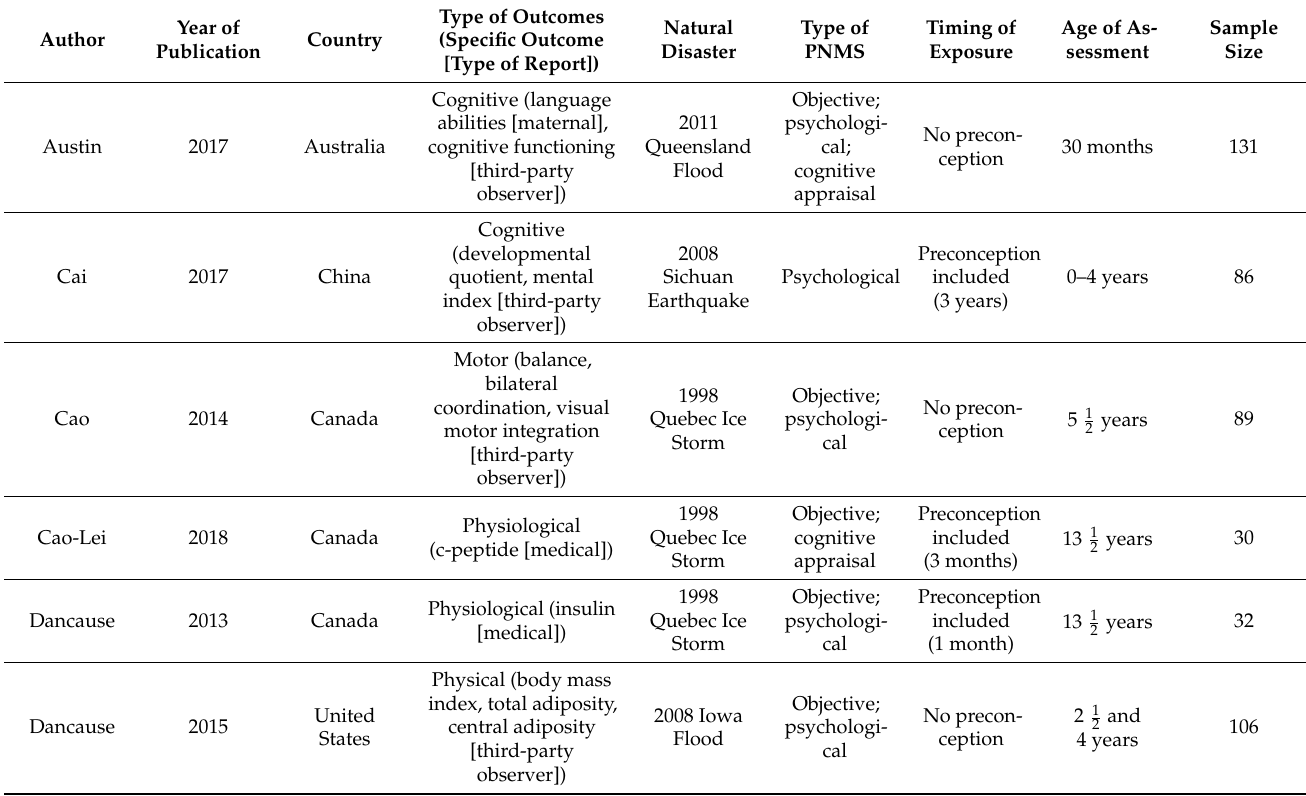
Table 1. Characteristics of studies included in the